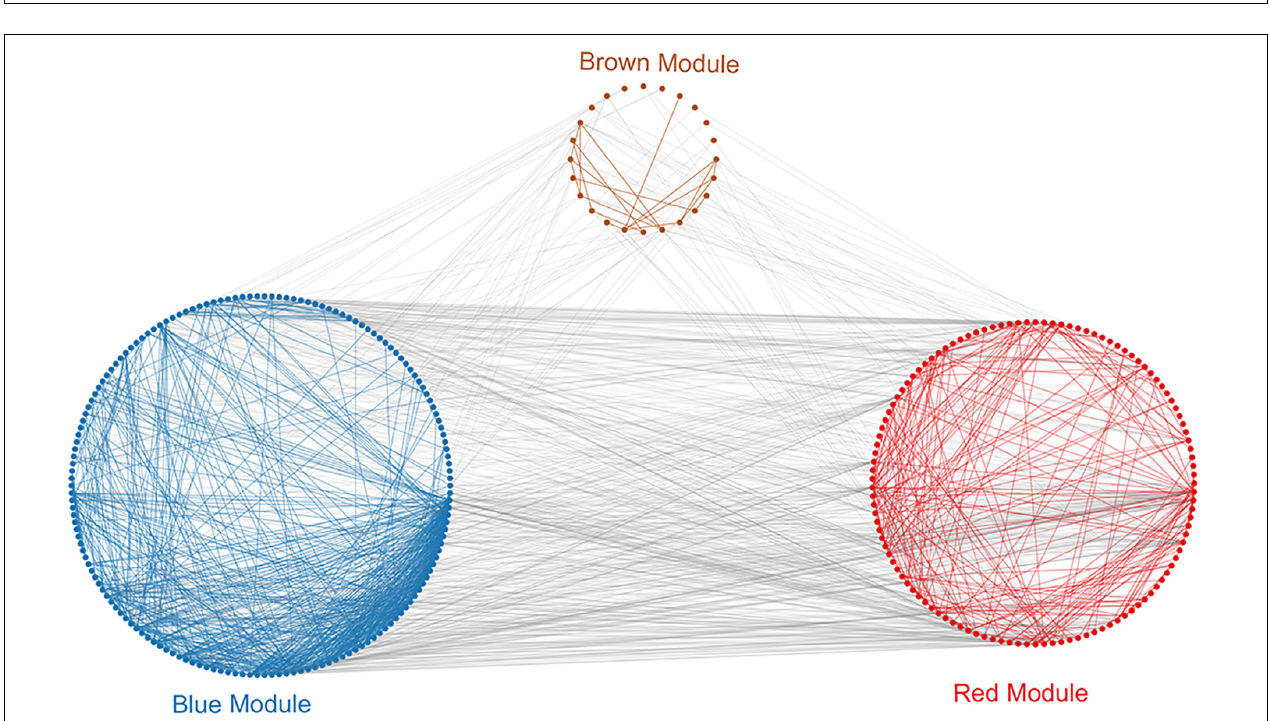
FIGURE 3 | Weighted gene coexpression network analysis (WGCNA) analysis based on clinical characteristics in non-obstructive azoospermia (NOA). (A) Soft threshold selection in WGCNA; 10 as the final soft threshold for subsequent analysis. (B) Module cluster analysis of differentially expressed genes (DEGs). Cluster analysis of different genes. Group genes with similar expressions into one module. (C) Correlation analysis between modules and clinical characteristics. The number above represents the correlation coefficient, and the number below represents the P value. The red in the figure represents a positive correlation between the two immune components. Blue means there is a negative correlation between the two. The darker the color, the stronger the correlation. Correlation coefficient > 0.25 means there is an interaction relationship. (D) Enrichment analysis of clinical traits in the related modules.